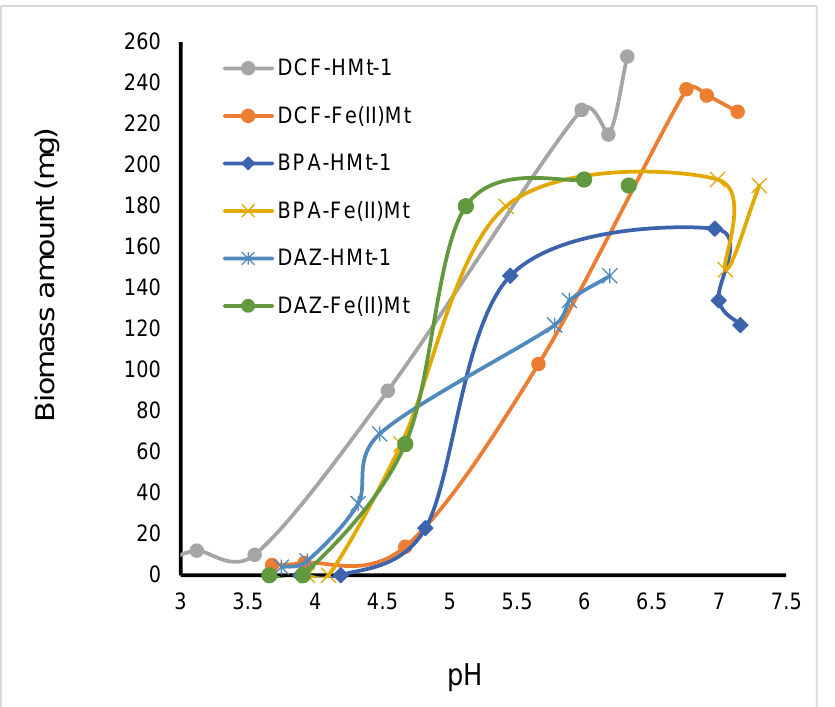
Figure 12. Effect of pH of the ozonized clay-substrate mixtures on the biomass amount. The biomass amount was measured by gravimetry on an analytical balance. All toxicity tests were achieved i. at constant pH 6.5 adjusted after ozonation and ii. at pH i , the pH of the SIS mixture with the solution of the organic substrate before and after ozonation at different times.